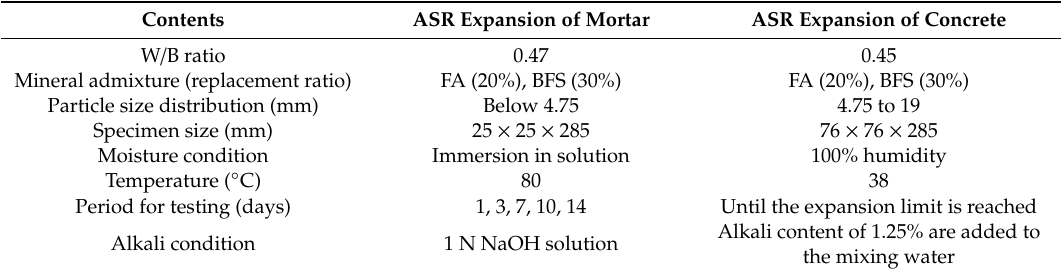
Table 3. Test variables.